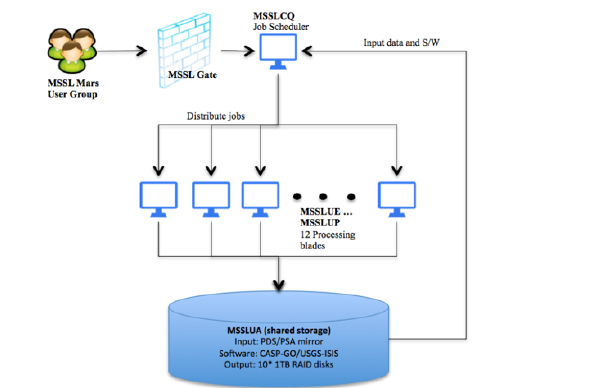
Figure 4. Schematic flowchart of the distributed linux multi- blade processing system used to process the thousands of CTX stereo-pairs using CASP-GO [4]